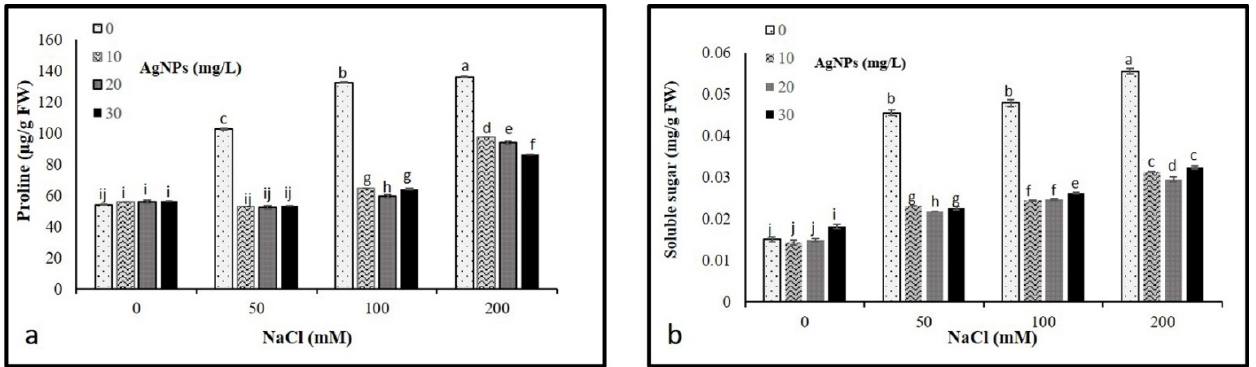
Figure 5. Osmolytes contents ( a ) proline and ( b ) total sugars in Maerua oblongifolia leaves under salt stress and application of silver nanoparticles. Means ± SD for each treatment followed by the same letters are not significantly different according to the Duncan’s test ( p ≤